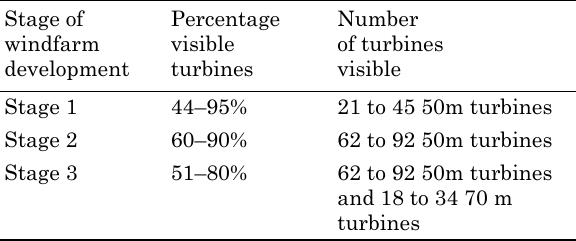
Table 1. Turbine visibility from Ashhurst